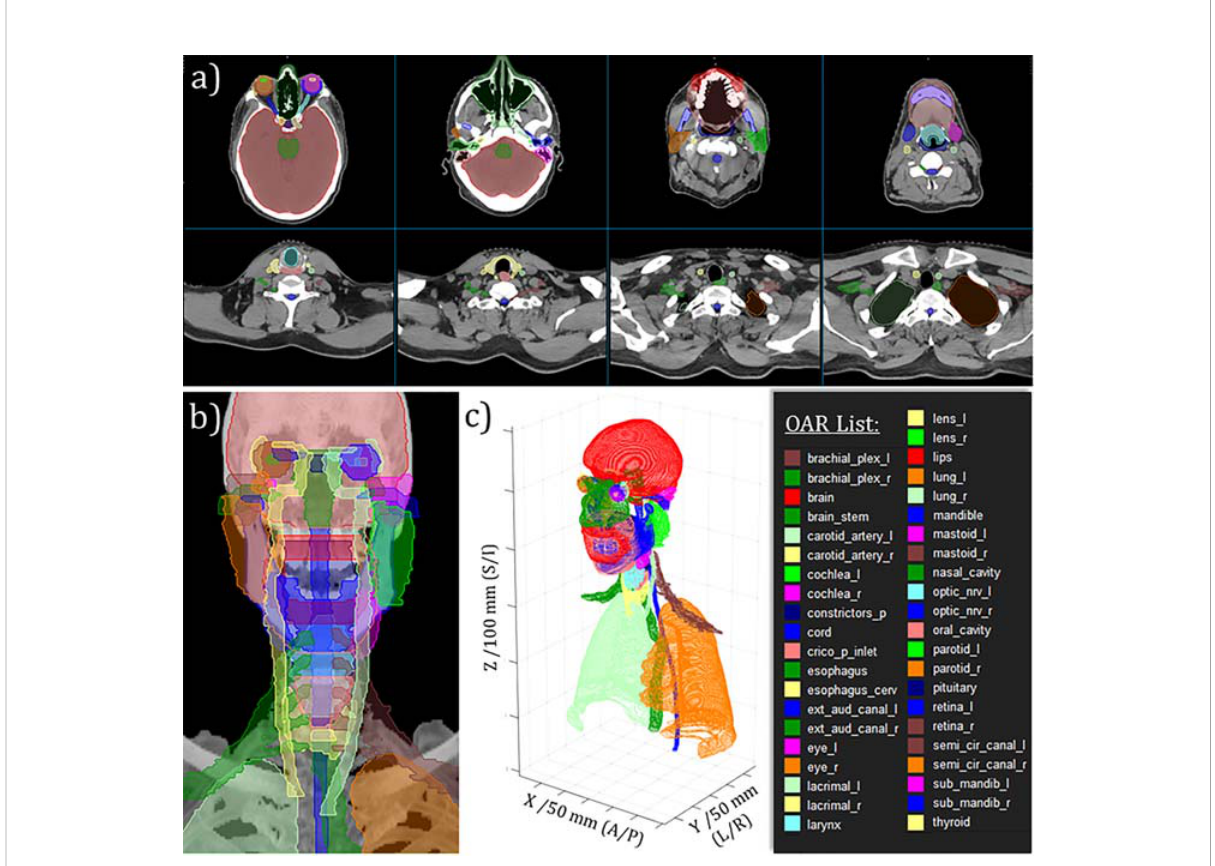
FIGURE 3 Example of curated H&N OAR segmentations for randomly selected case. (A) Moving from left-to-right, top-to-bottom: selected axial slices moving from superior to inferior aspect of H&N RT planning CT. (B) Anterio-posterior maximum intensity projection rendering with OAR projections overlayed. (C) 3D perspective rendering of 2D DICOM-RTStruct-format OARs with tick-marked scales on DICOM coordinates as